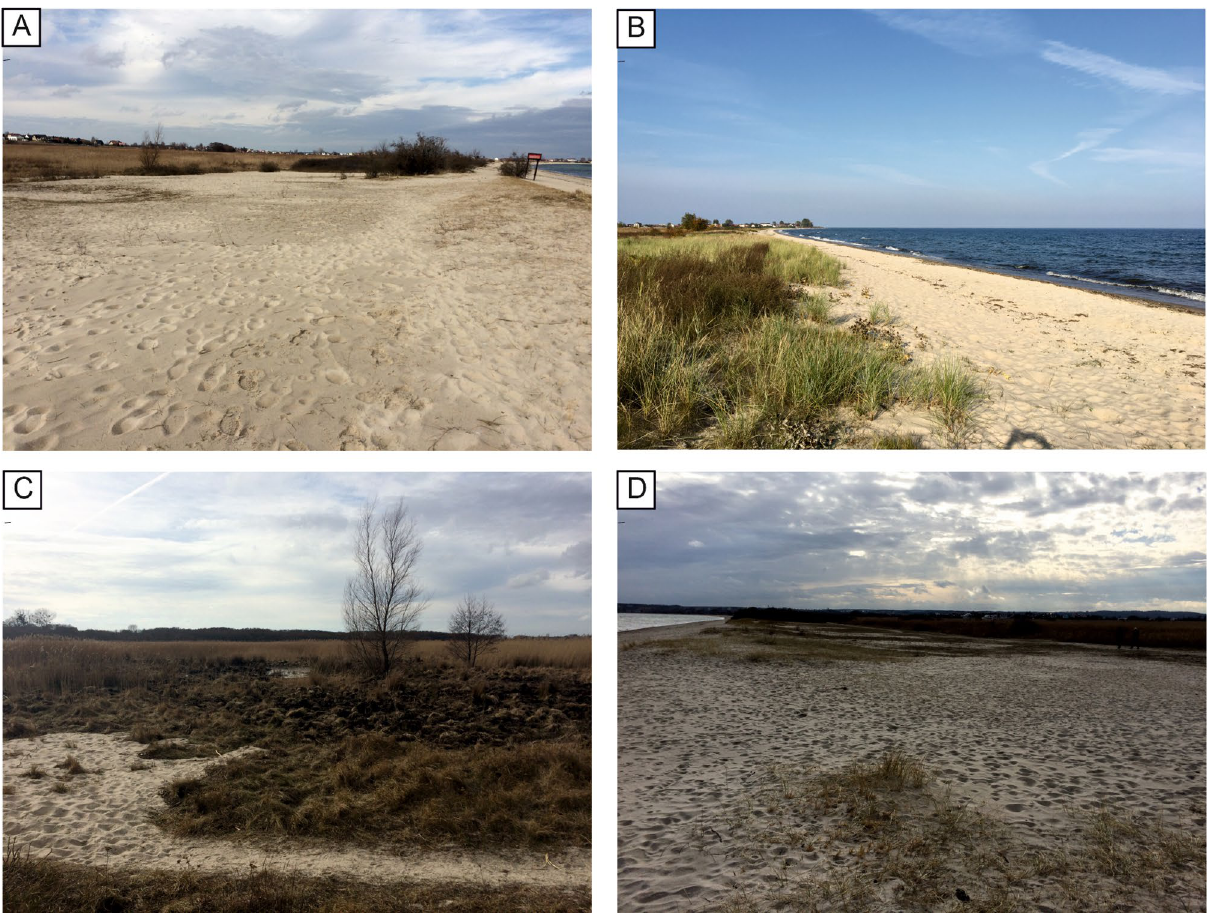
Figure 2. Photos of the Mechelinki research area (photo: K. Leszczyńska – all). ( A ) View to the north with recent washover fan (to the left) entering the wetland . ( B ) View to the north with the modern beach and foredune up to 2 m high. ( C ) View to the east, landward with partly stabilized foredune and wetland behind. ( D ) View to the south with the modern beach and foredune up to 2 m high. For locations of the photos see Fig.